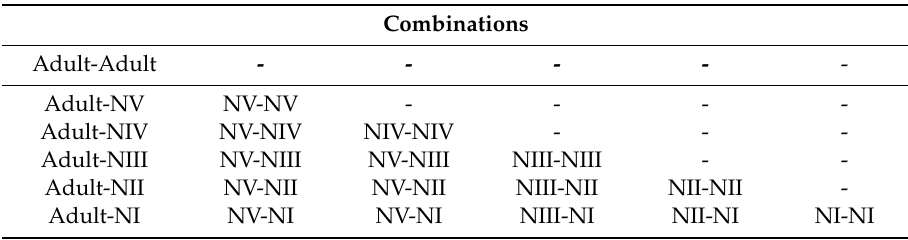
Table A2. Combinations used in the IGP N. pseudoferus – N. tenuis , assay 1, under laboratory conditions and without alternative prey, when both predatory species are in the same or lower stage class.